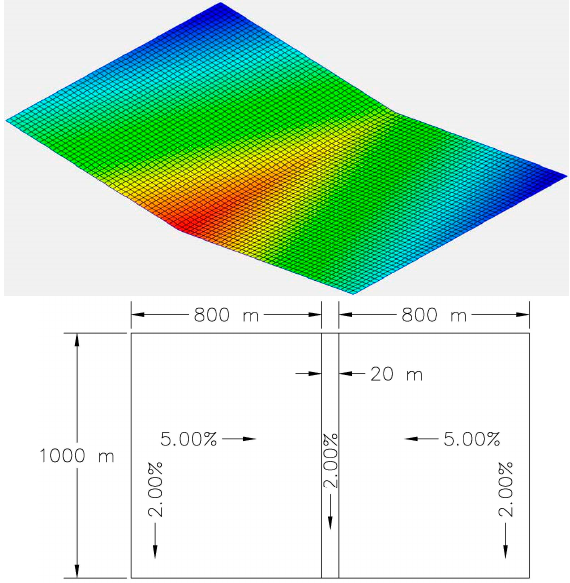
Figure 3. Tilted V-Catchment test case domain [4,13,15].